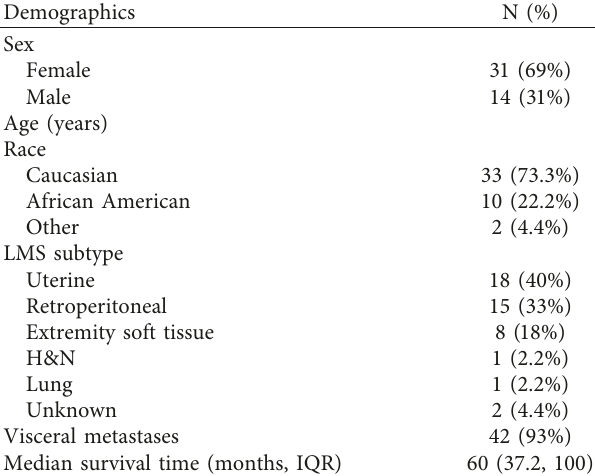
Table 2: Demographics of the 45 patients with metastatic LMS to